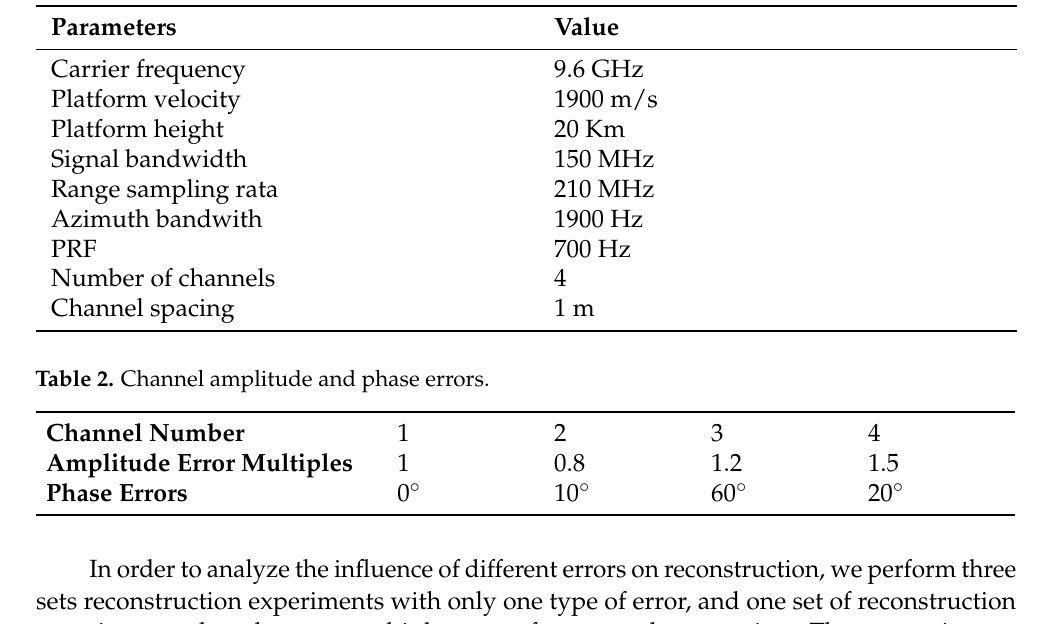
Table 1. Multichannel SAR simulation parameters.